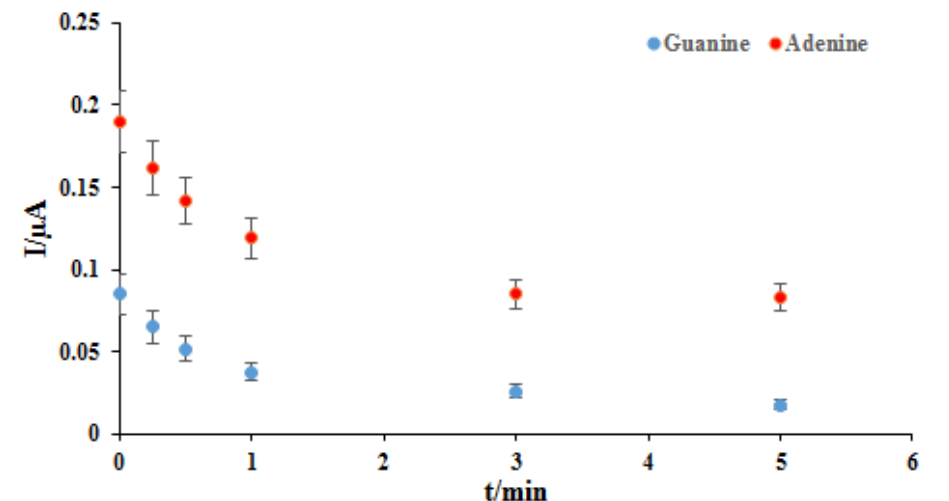
Figure 4. The plot of the guanine (blue dots) and adenine (red dots) peaks current vs. different interaction times with the ELT.